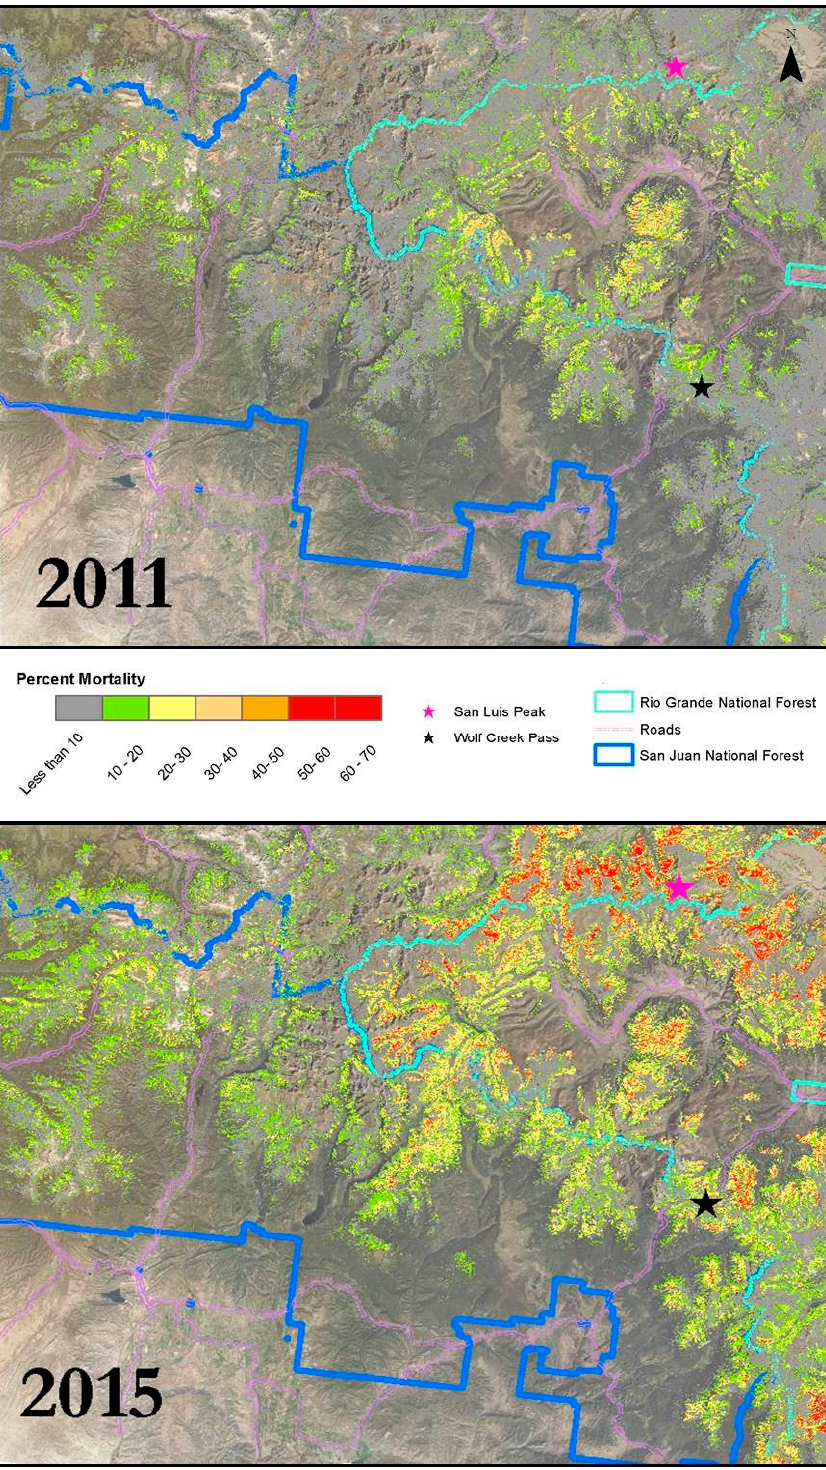
Figure 4. Final predictions of percent gray stage canopy mortality in and around Rio Grande and San Juan National Forests in 2011 and 2015.